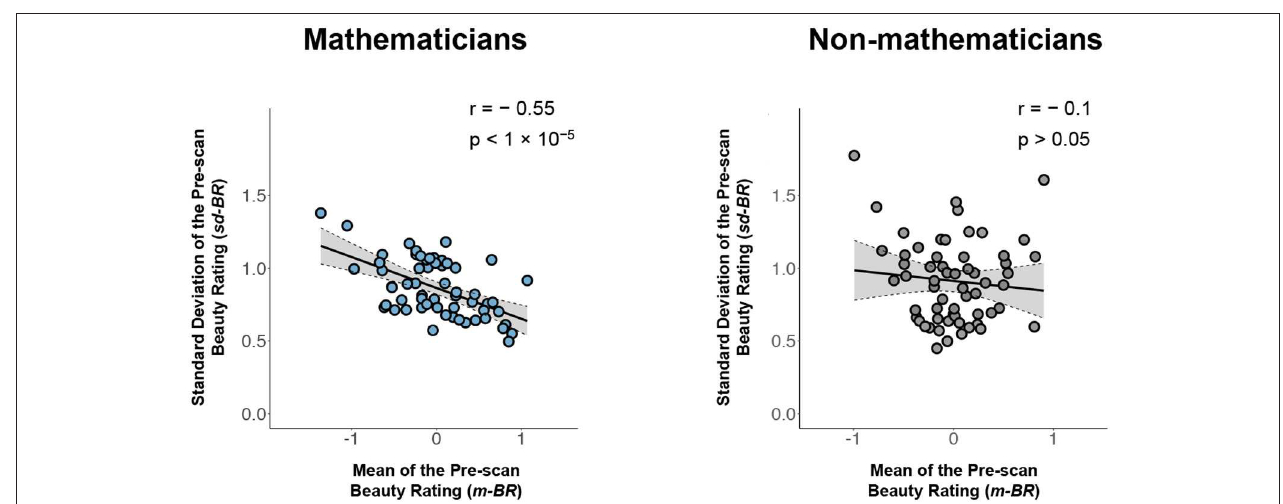
FIGURE 2 | Left: A plot of the mean pre-scan beauty rating (m-BR) for each equation against the standard deviation (sd-BR) of the ratings given to each equation for mathematicians (Pearson r : 0.55, p < 10 − 5 ). Right: The same plot for non-mathematicians (Pearson r : − its value on the horizontal line indicates the average beauty ratings of the equation across all subjects and its value on the vertical line indicates the standard deviation of the beauty ratings. Gray area indicates the 95% confidence band for best-fit